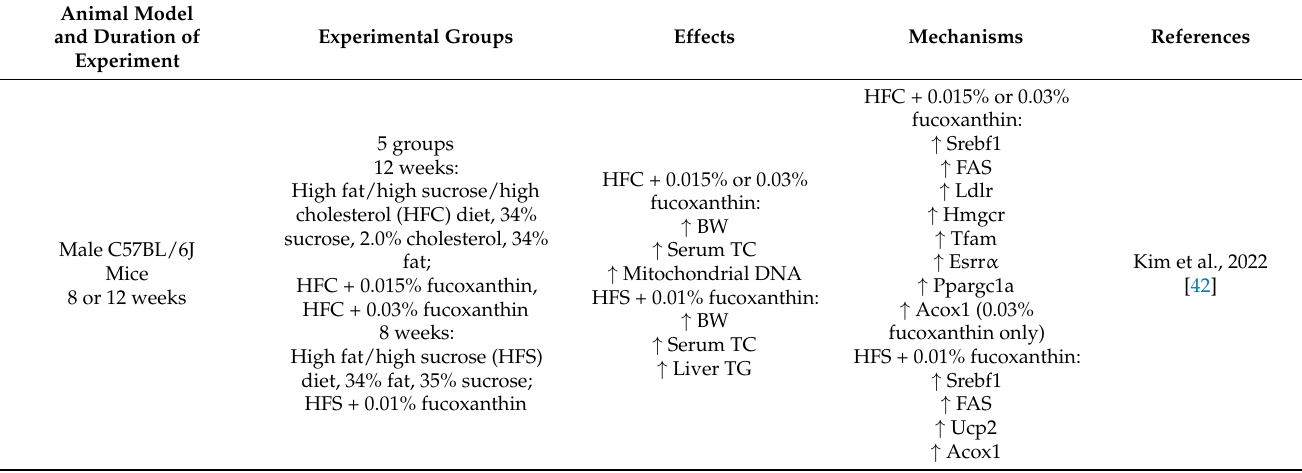
Table 2. Effects of fucoxanthin on NAFLD in animal